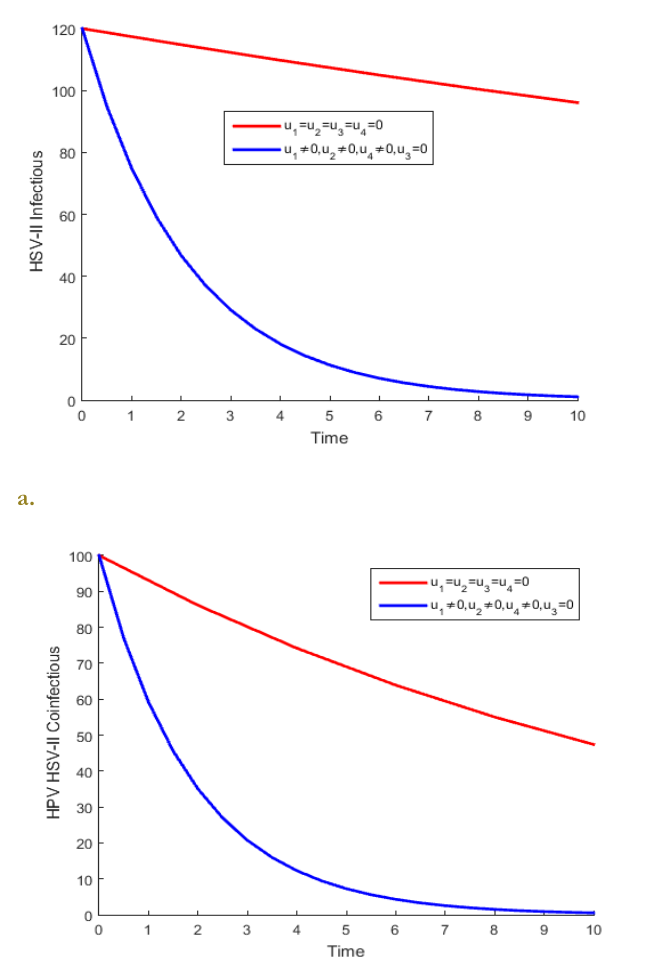
Fig. 2. Simulations showing optimal use of HPV prevention, HPV treatment and HSV-II treatment. Intervention III. Optimal use of HPV prevention, HSV-II prevention and HSV-II